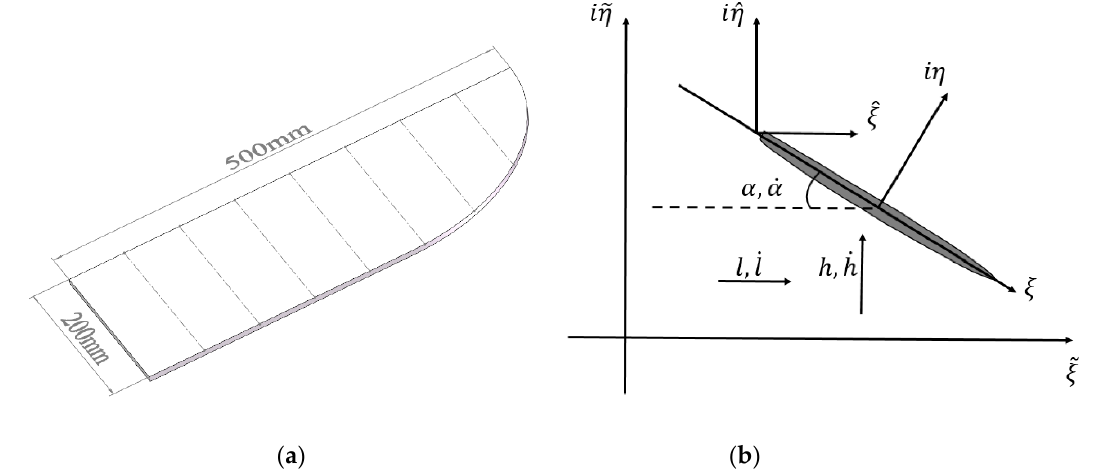
Figure 2. ( a ) The 3D wing platform and dimension; ( b ) a 2D airfoil in inertial coordinate system.